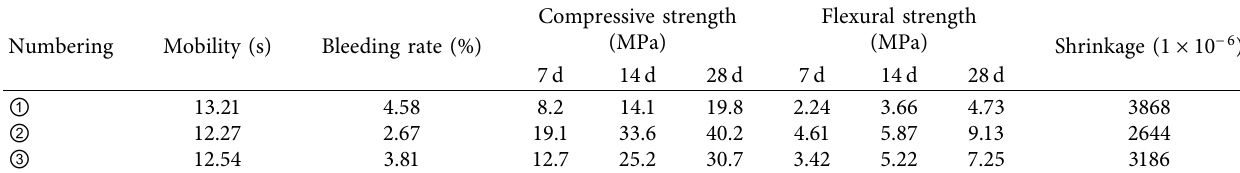
Table 9: Performance test